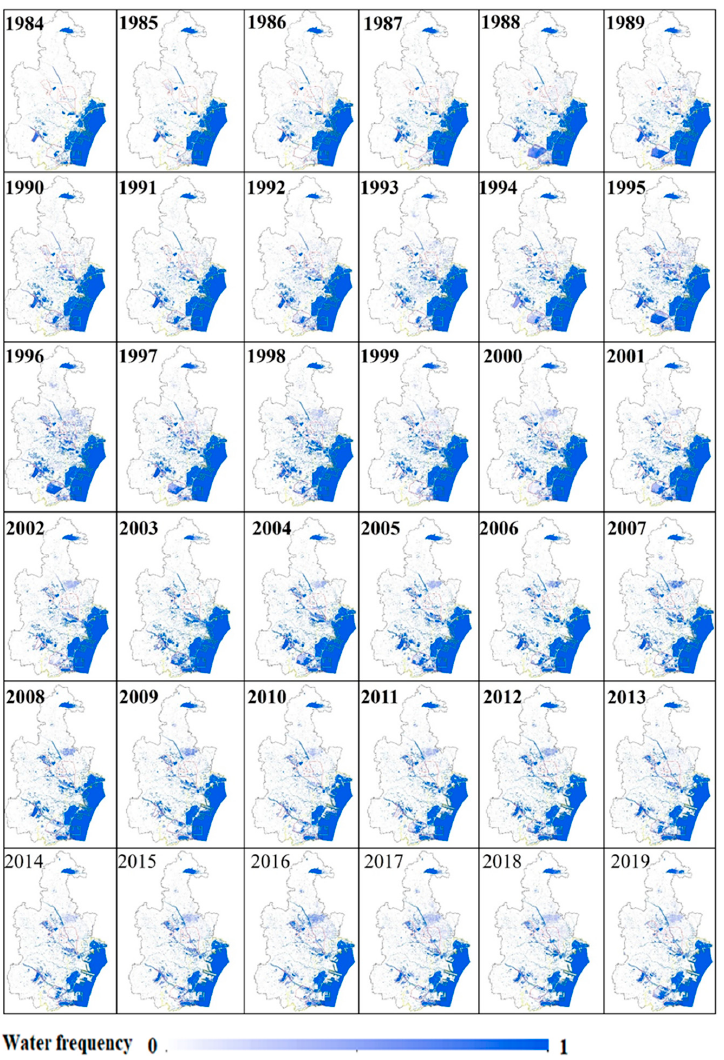
Figure 5. Annual water frequency map of Tianjin during 1984–2019. To present the details of the water changes in Tianjin, six typical regions were selected from Tianjin to show the long-term changes of water area. Figure 6 plots the estimated areas of water and permanent water bodies between 1984 and 2019, Figure 6a–g represent the results of ACWNNR, BWNR, DWNR, TBNR, BHNA, YR and Tianjin, respectively. All the cloud-free images in the corresponding area were considered when calculating the long-term changes. The coverages of the water area showed a seasonal and annual fluctuation trend during 1984–2019 for the ACWNNR, BWNR and DWNR (Figure 6a–c). The water area within TBNR showed a remarkable seasonal and annual fluctuation from 1984 to 2019, which almost dried up in the periods (1992–1994, 1999–2004, and 2008–2011) and remained at a fluctuated level (46.2~54.6km 2 ) after 2012 (Figure 6d). Specifically, the water area showed a fluctuation trend in the period (1984–2003) and a significant shrinking trend ( − 28.7 km 2 yr − 1 , p < 0.05) after 2003 for the BHNA (Figure 6e). The water area of YR had a significant seasonal variation (Figure 6f). The permanent water area (in- cluding permanent shallow marine water and inland water) of Tianjin decreased 282.5 km 2 from 1984 to 2019.